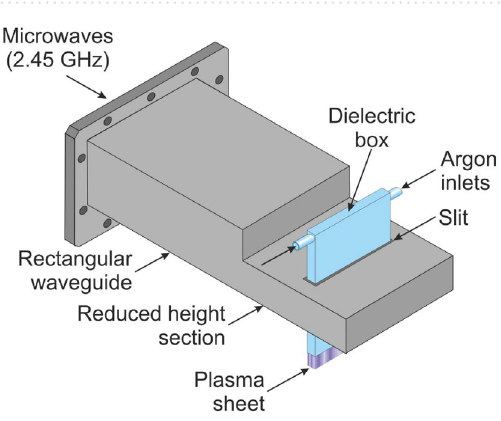
Figure 2. Schematic diagram of the experimental setup.